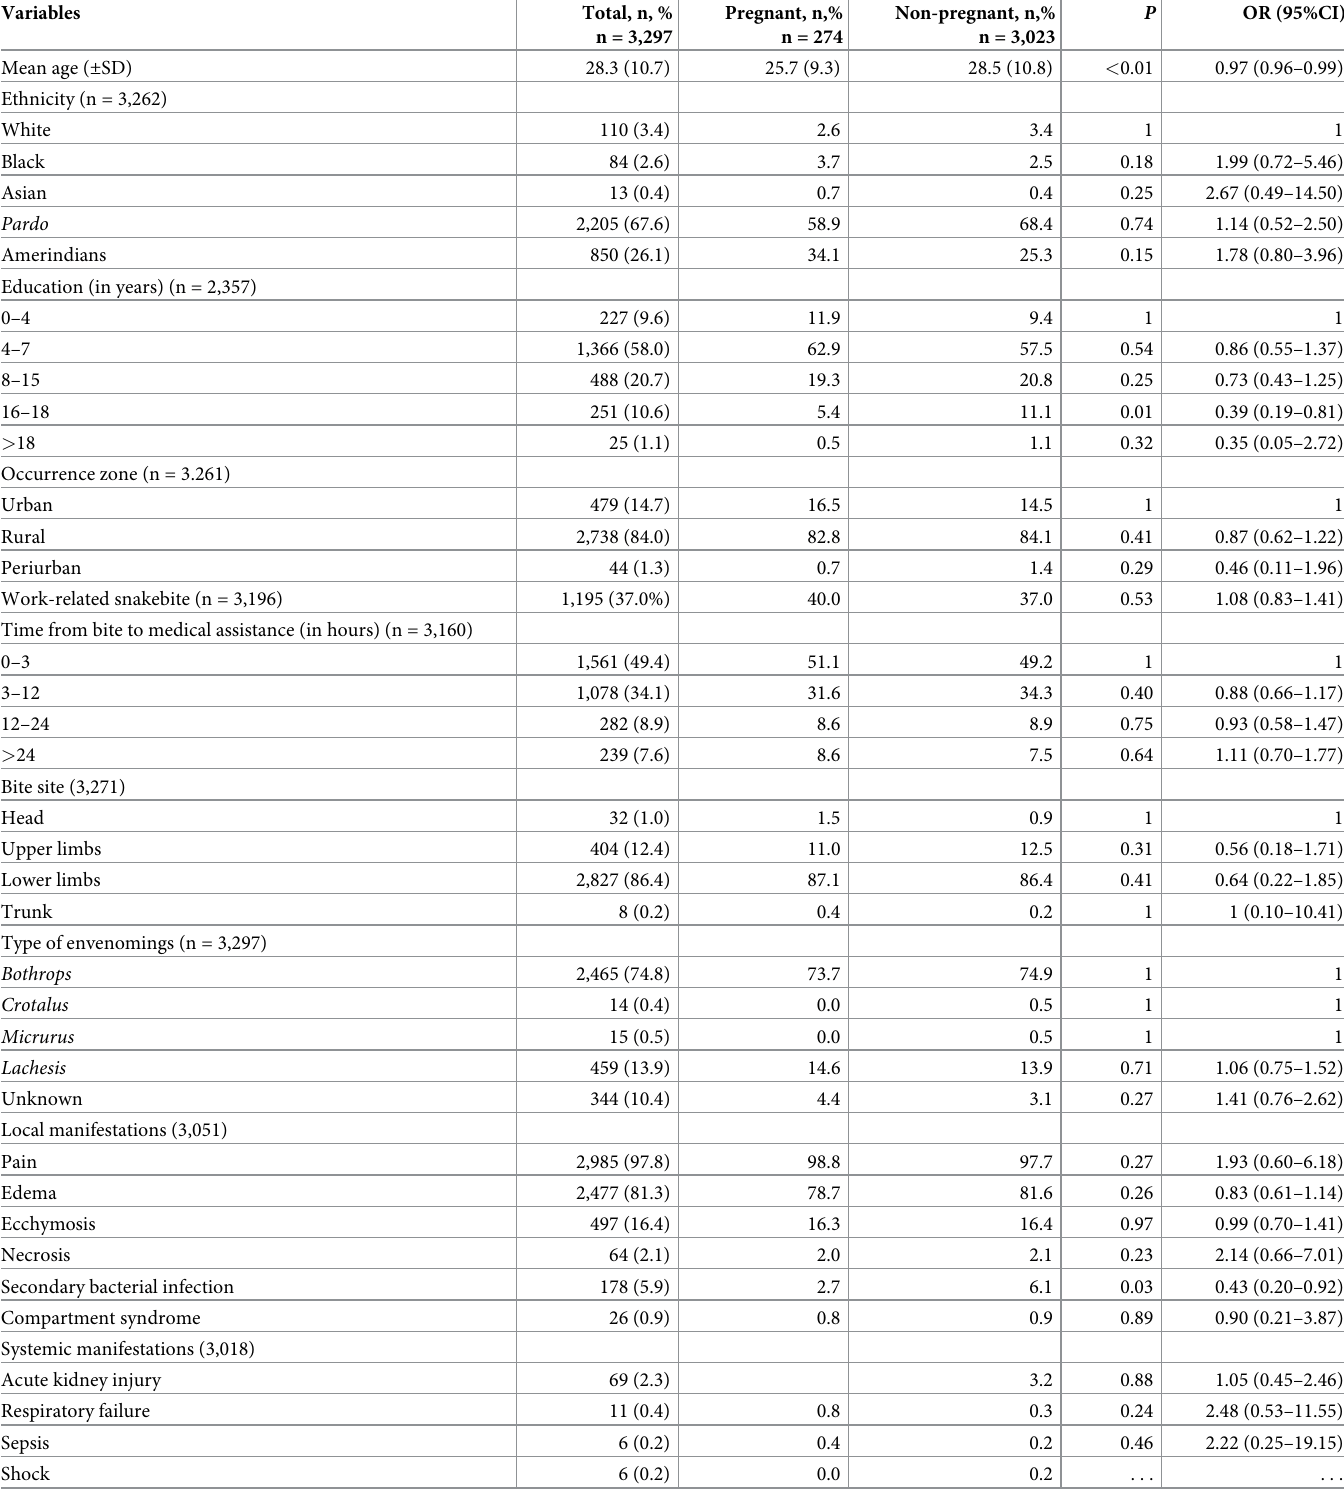
Table 1. Demographic and clinical aspects between pregnancy and women of childbearing